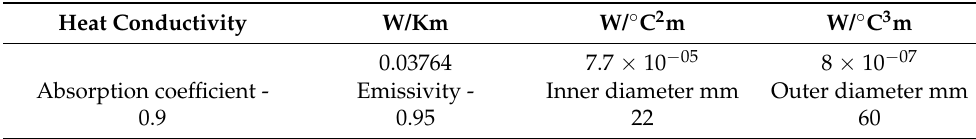
Table A2. Material properties of the pipe insulation.